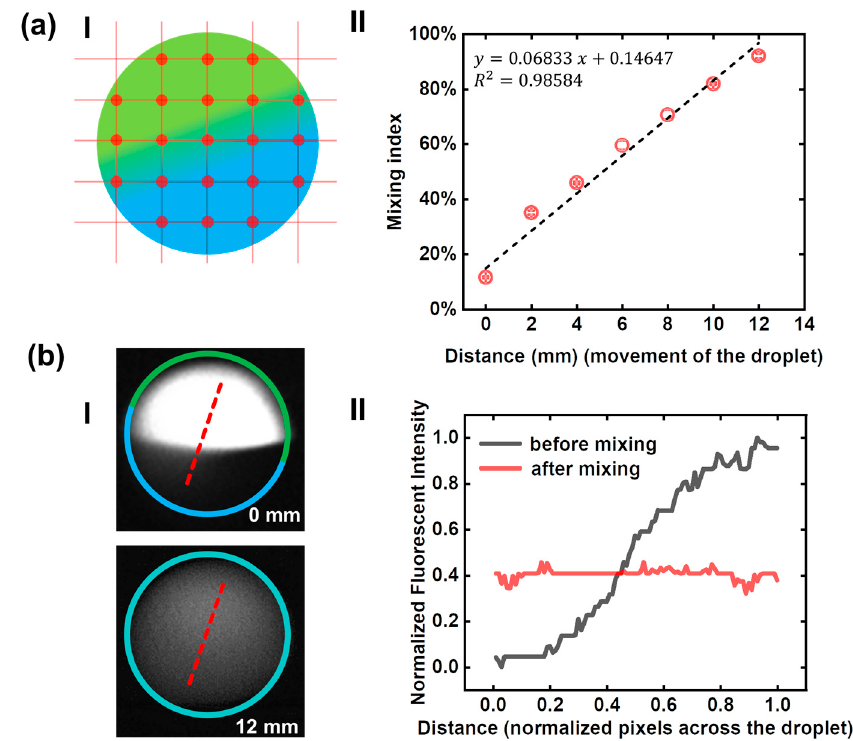
Figure 5. Calculation of mixing index (MI). ( a ) I : There were twenty-one points selected in each fluorescent image for intensity analysis, which can be used to calculate the mixing index (MI). II : Mixing index of droplets at different traveling distances. ( b ) I : Two dash line scans across the microphotographs of the unmixed and mixed droplets. II : The distribution of fluorescence intensity of the rotating droplet is uniform compared with the initial state.